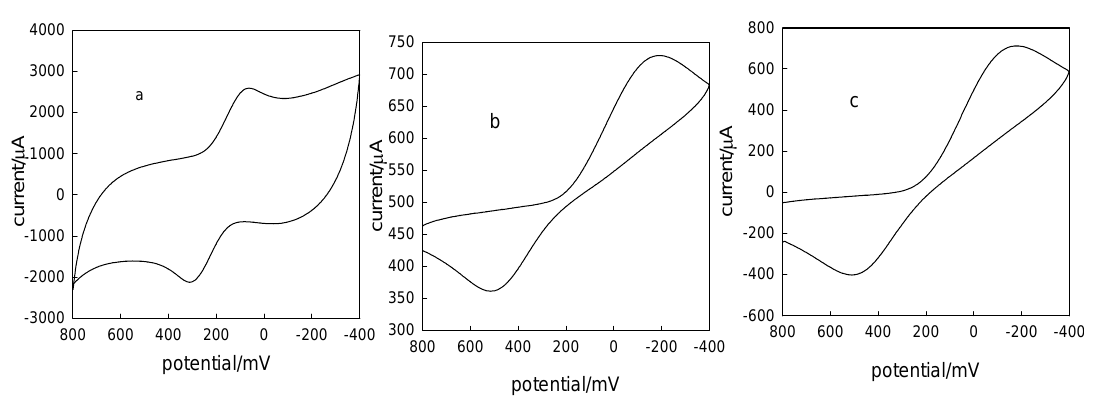
Figure 4. Cyclic voltammograms obtained with the CLTNPE (a), GC (b) and CPE (c) in 20 mmol·L -1 potassium ferricyanide containing 0.1 mol·L -1 KCl (pH 7.0). Scan rate: 50 mV·s -1 .